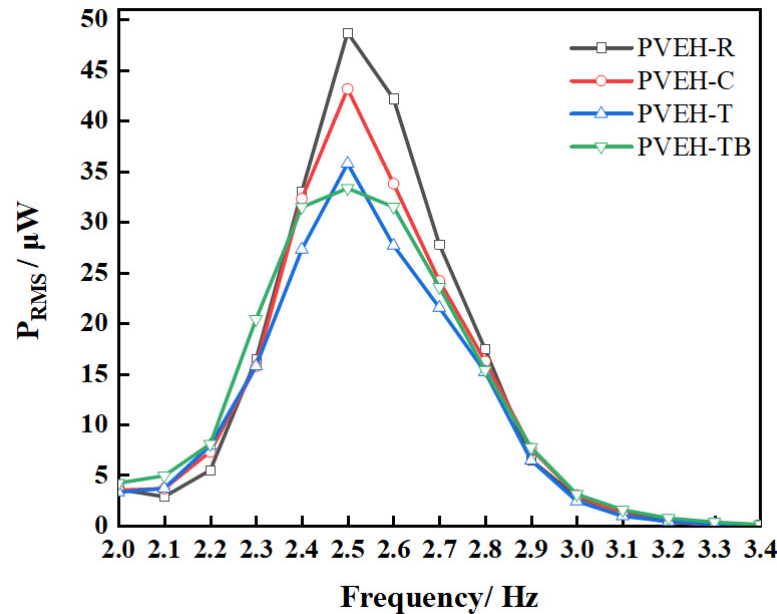
Figure 12. The effect of float shape on the PVEH output